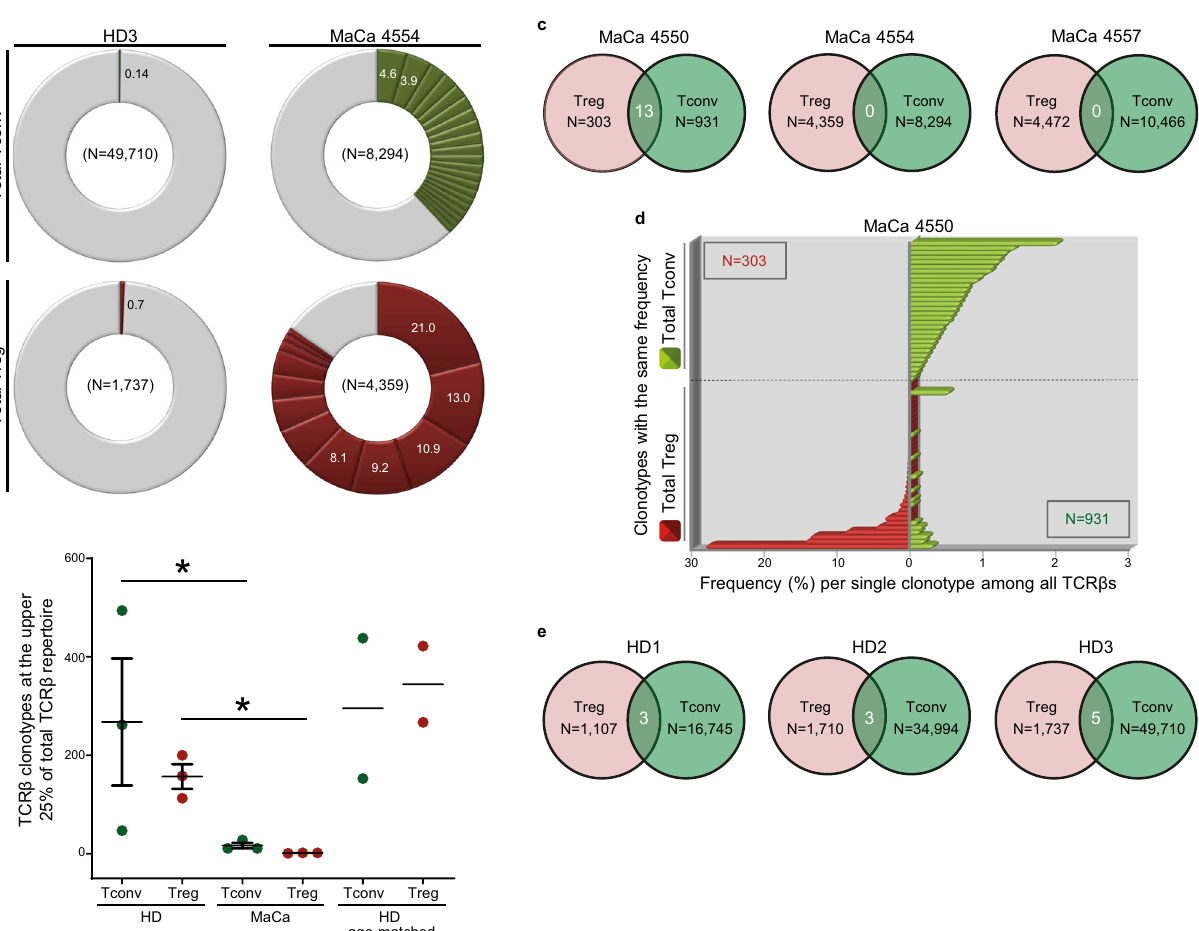
Fig. 2 Minor TCR similarity between Tconv and Treg in PB of breast cancer patients and healthy individuals. a Pie chart of all clonotypes in order of decreasing percentage (%) among total Tconv (green) and total Treg (red) from one representative breast cancer patient with mammary gland adenocarcinoma (MaCa: n = 3) and one healthy donor (HD: n = 3), n refers to biologically independent replicates. Gray slices correspond to the TCR β repertoire fraction that contains clonotypes with a frequency below 1%. b The absolute number of clonotypes accounting for the highest 25% of the TCR β repertoire in Treg (red) and Tconv (green) from HD versus MaCa. Cumulative data (HD: n = 3, MaCa: n = 3, HD age-matched: n = 2), n refers to biologically independent replicates. Data are presented as mean values for HD age-matched ( n = 2) or as mean values + /- SEM. *P ≤ 0.05 signi fi cant differences between the groups connected with a line, two-sided t test on rank data ( P = 0.021 for the comparison of Tconv in three HDs versus three MaCa patients and P = 0.021 for the comparison of Treg in three HDs versus three MaCa patients). c , e Venn diagram of the number of overlapping clonotypes (white) between Treg and Tconv within each ( c ) MaCa patient or ( e ) HD. d Frequency of overlapping clonotypes between Treg and Tconv compared to the frequencies of all clonotypes identi fi ed per subset in order of decreasing (Treg, red) and increasing (Tconv, green) frequency in patient MaCa 4550. Due to the big number of identi fi ed clonotypes per subset, each bar represents a group of clonotypes with identical frequencies ( y axis) plotted against the frequency of each clonotype in this group ( x axis). Clonotypes of each subset are separated by a dashed black line. In case of an overlapping clonotype between the two subsets, a red and a green bar align on the y axis. N , total number of clonotypes among Treg (red) and Tconv (green). Source data are provided as a Source Data fi